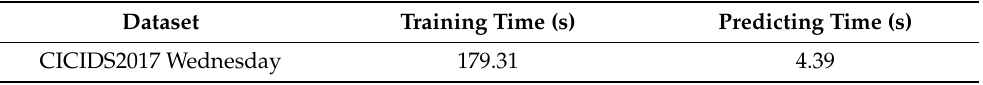
Table 10. Training and predicting time on the CICIDS2017 Wednesday.